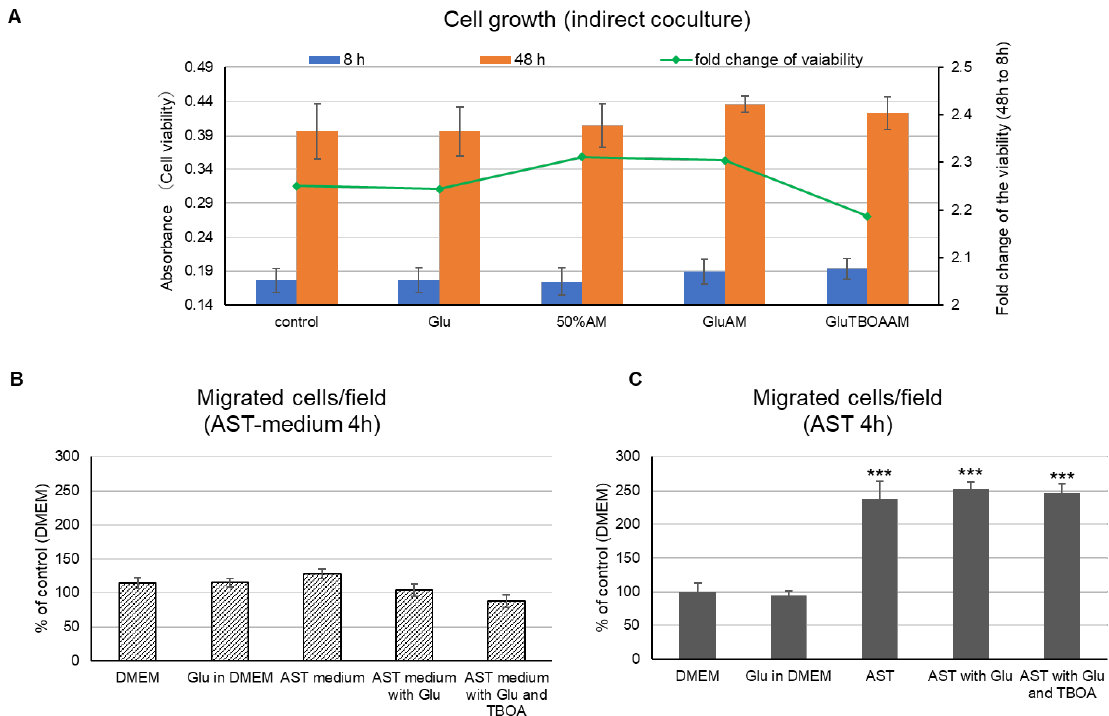
Figure 3. Effect of glutamate (Glu) exposure to astrocytes on the MDA231 phenotype. ( A ) Cell growth of MDA231 after indirect coculture. Control—MDA231 cultured in Dulbecco’s modified Eagle’s medium (DMEM); Glu—MDA231 cultured in 3 µ M Glu; 50% astrocyte culture supernatant (50%AM) —MDA231 performed indirect coculture with 50% diluted astrocytes culture supernatant; GluAM—MDA231 performed indirect coculture with astrocytes exposed to 3 µ M Glu; GluTBOAAM— MDA231 performed indirect coculture with astrocytes exposed to 3 µ M Glu and 100 µ M of threo- β -benzyloxyaspartate (TBOA) (excitatory amino acid transporter (EAAT) inhibitor). Bar graphs show cell viability at 8 h or 48 h, showing mean ± SEM (n = 6). The line graph shows fold change of the viability calculated by dividing the cell viability at 48 h by that at 8 h. ( B , C ) Cells were migrated via the Boyden chamber insert after the same procedure as in ( A , B ) in the case of indirect coculture or ( C ) in the presence of astrocytes in lower well. Data are shown as mean ± SD (n = 3). *** p < 0.001, Tukey-Kramer test vs. DMEM (control)